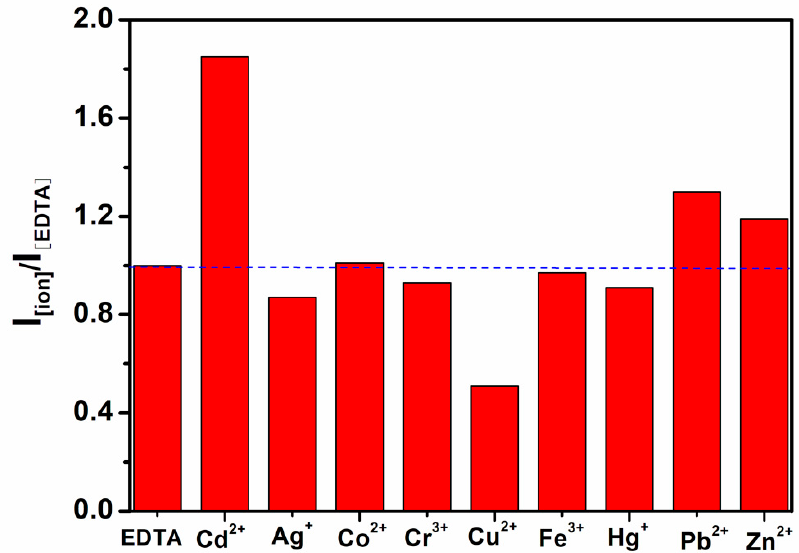
Figure 6. Influence of different metal ions on the system in the Tris ‐ HCl buffer.